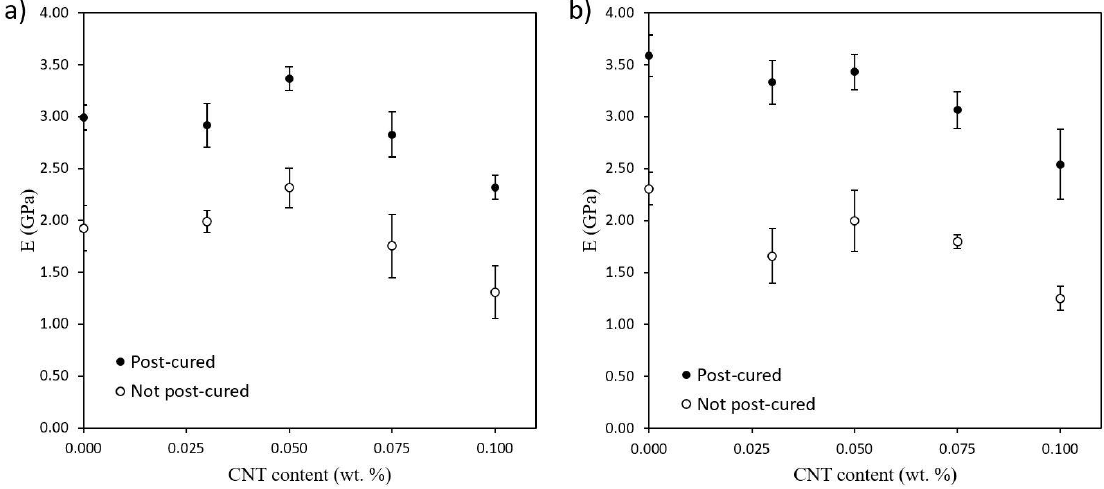
Figure 8. Young’s modulus of 3D printed specimens as a function of CNT content. ( a ) Tensile tests and ( b ) three-point bending tests.